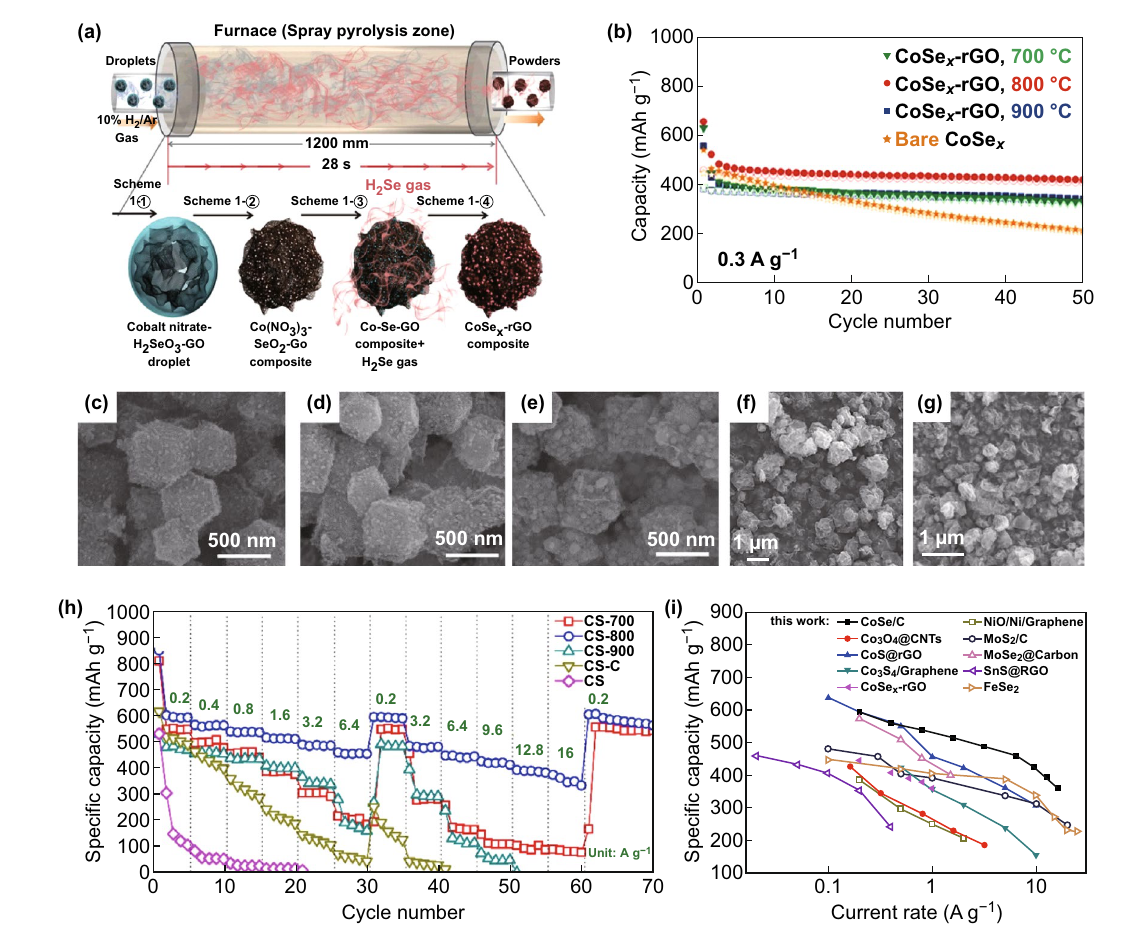
Fig. 6 a Formation mechanism of CoSe x –rGO composite powder by one-pot spray pyrolysis process. b Electrochemical properties of the bare CoSe x and CoSe x –rGO composite powders’ cycling performance. SEM and TEM images of the CoSe/C composites synthesized at different temperatures, c CS-700, d CS-800, e CS-900. SEM image, SAED pattern, and elemental mapping image of the CoSe x –rGO composite